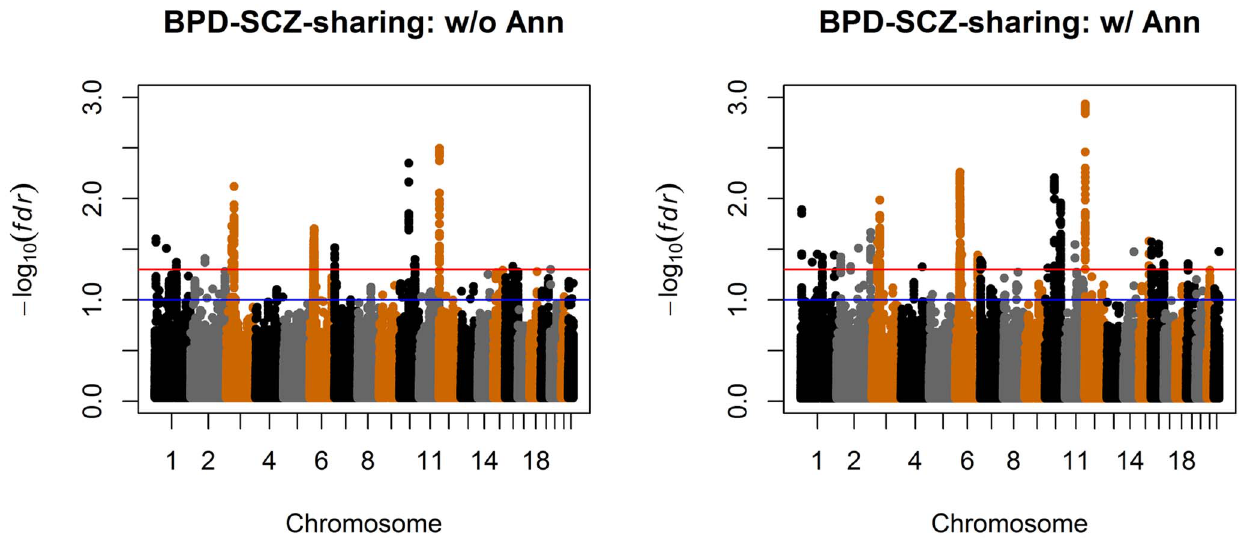
Figure 7. Manhattan plots of local false discovery rates fdr 1 , 2 ( P j 1 , P j 2 ) and fdr 1 , 2 ( P j 1 , P j 2 , A ) (Equations (11) and (12)) for detecting BPD-SCZ-sharing SNPs. Left panel: joint analysis without annotation. Right panel: joint analysis with annotation. The red and blue lines indicate local fdr =0.05 and 0.1, respectively.